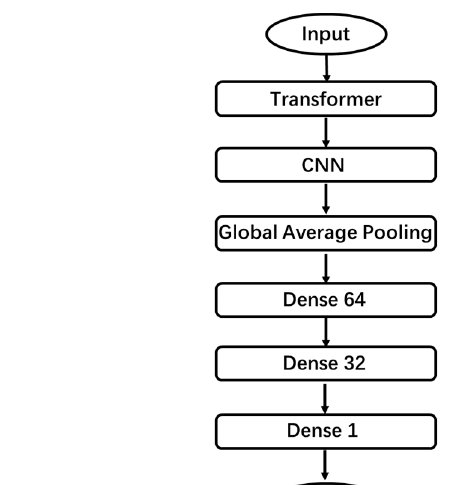
Figure 2. DDosTC overall architecture.